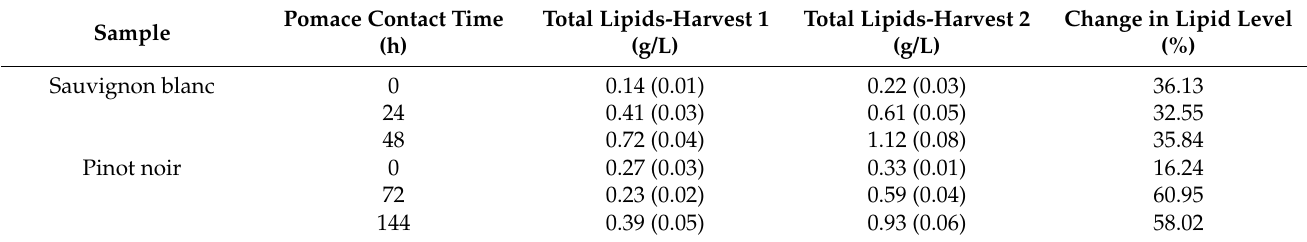
Table 4. Total lipids present in Sauvignon blanc and Pinot noir grape juices and the influence of pomace contact on extraction of lipids in the must.